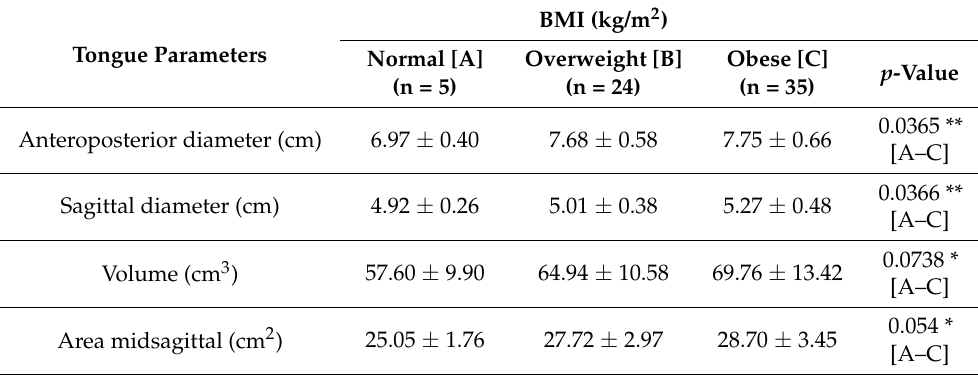
Table 5. MRI parameters of the tongue depending on BMI values. Parameters show the mean ± SD values. ** indicates the significant difference at p < 0.05 level and * the significant difference at p < 0.1 Only the significantly different parameters are shown in the